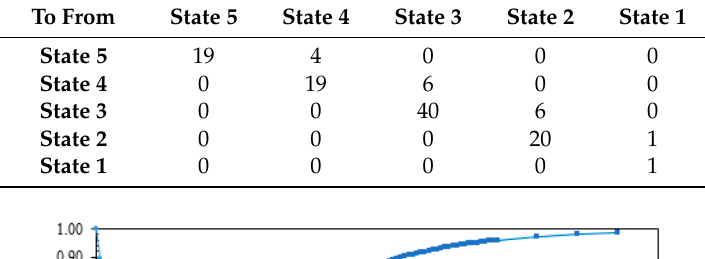
Table 6. Transition of transformer states for the year 2012/2013.